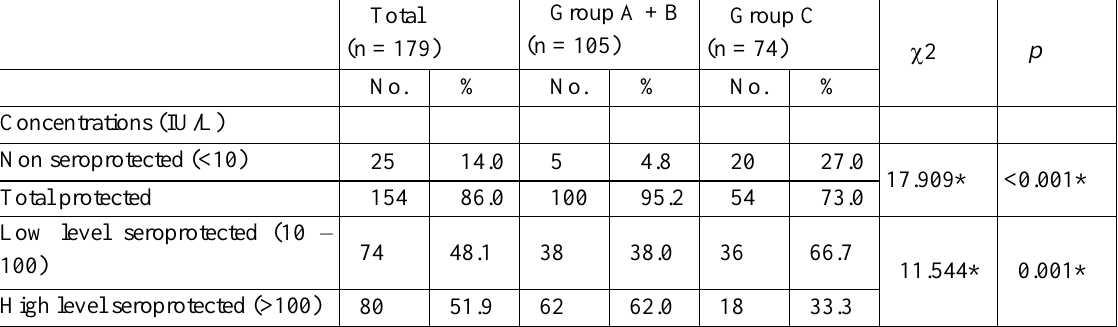
Table 2. Comparison between the two studied sectors according to anti-HBs concentrations